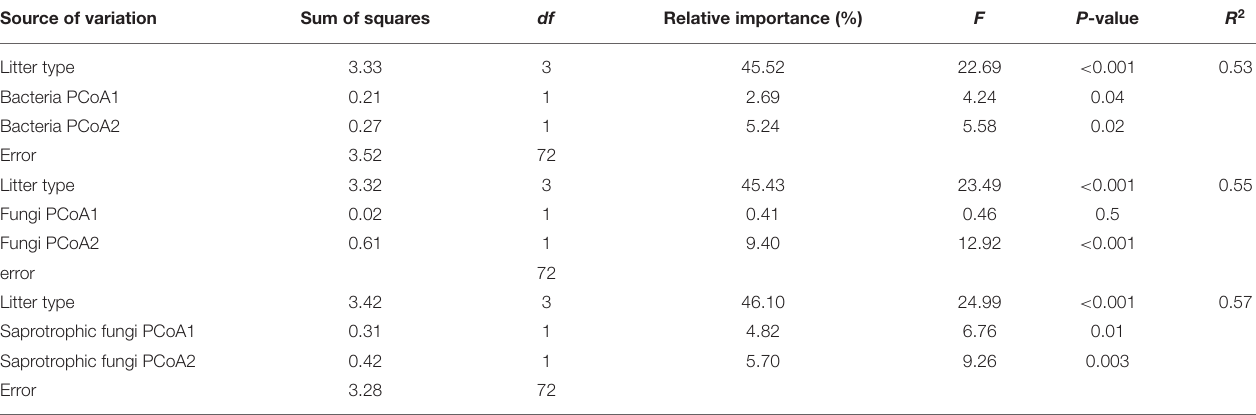
TABLE 5 | Multiple linear regression results from a model with litter mass loss (log-transformed) at 398 day as the dependent variable, litter type, and axis scores 1 and 2 from principal co-ordinates analysis (PCoA) of initial bacteria, fungal, and saprotrophic fungal community composition as independent variables. Source of variation Sum of squares df Relative importance (%) F P -value R 2 Litter type Bacteria PCoA1